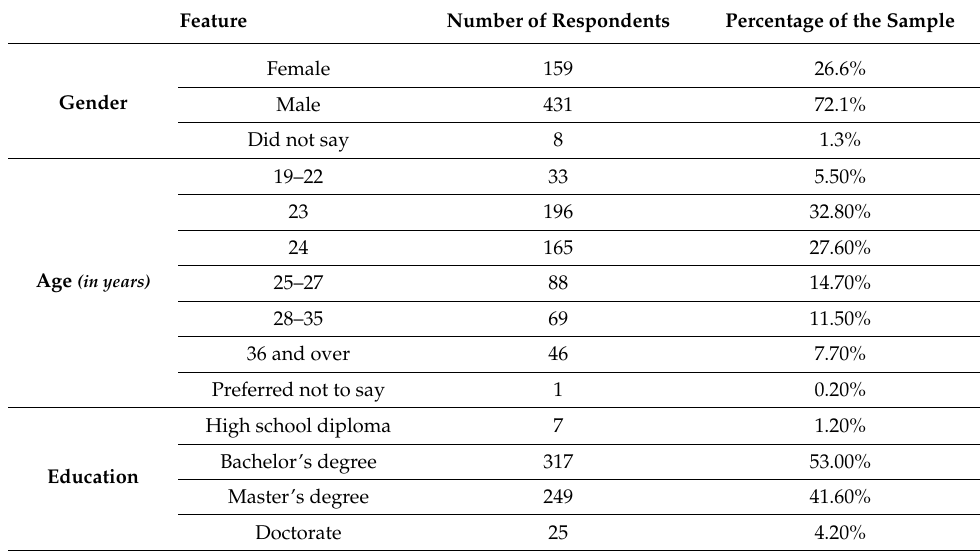
Table 1. Characteristics of the test sample (N =